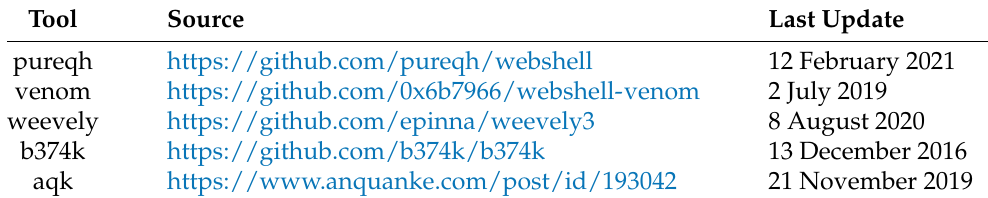
Table 8. The sources of the antidetect webshell generation tools.